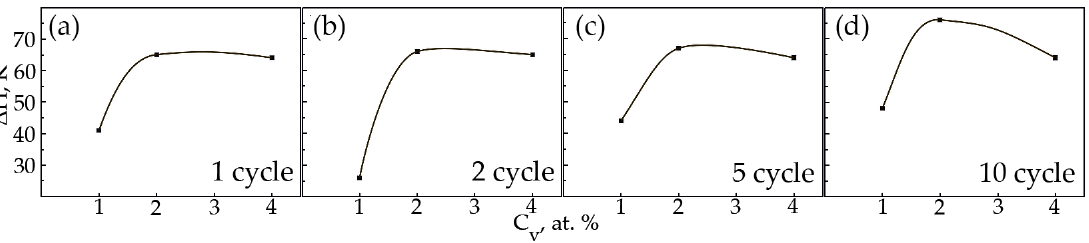
Figure 16. The width of the hysteresis loop on the temperature dependence of the deformation under constant load on the concentration V: ( a ) — 1 cycle; ( b ) — 2nd cycle; ( c ) — 5th cycle; ( d ) — 10 cycle.